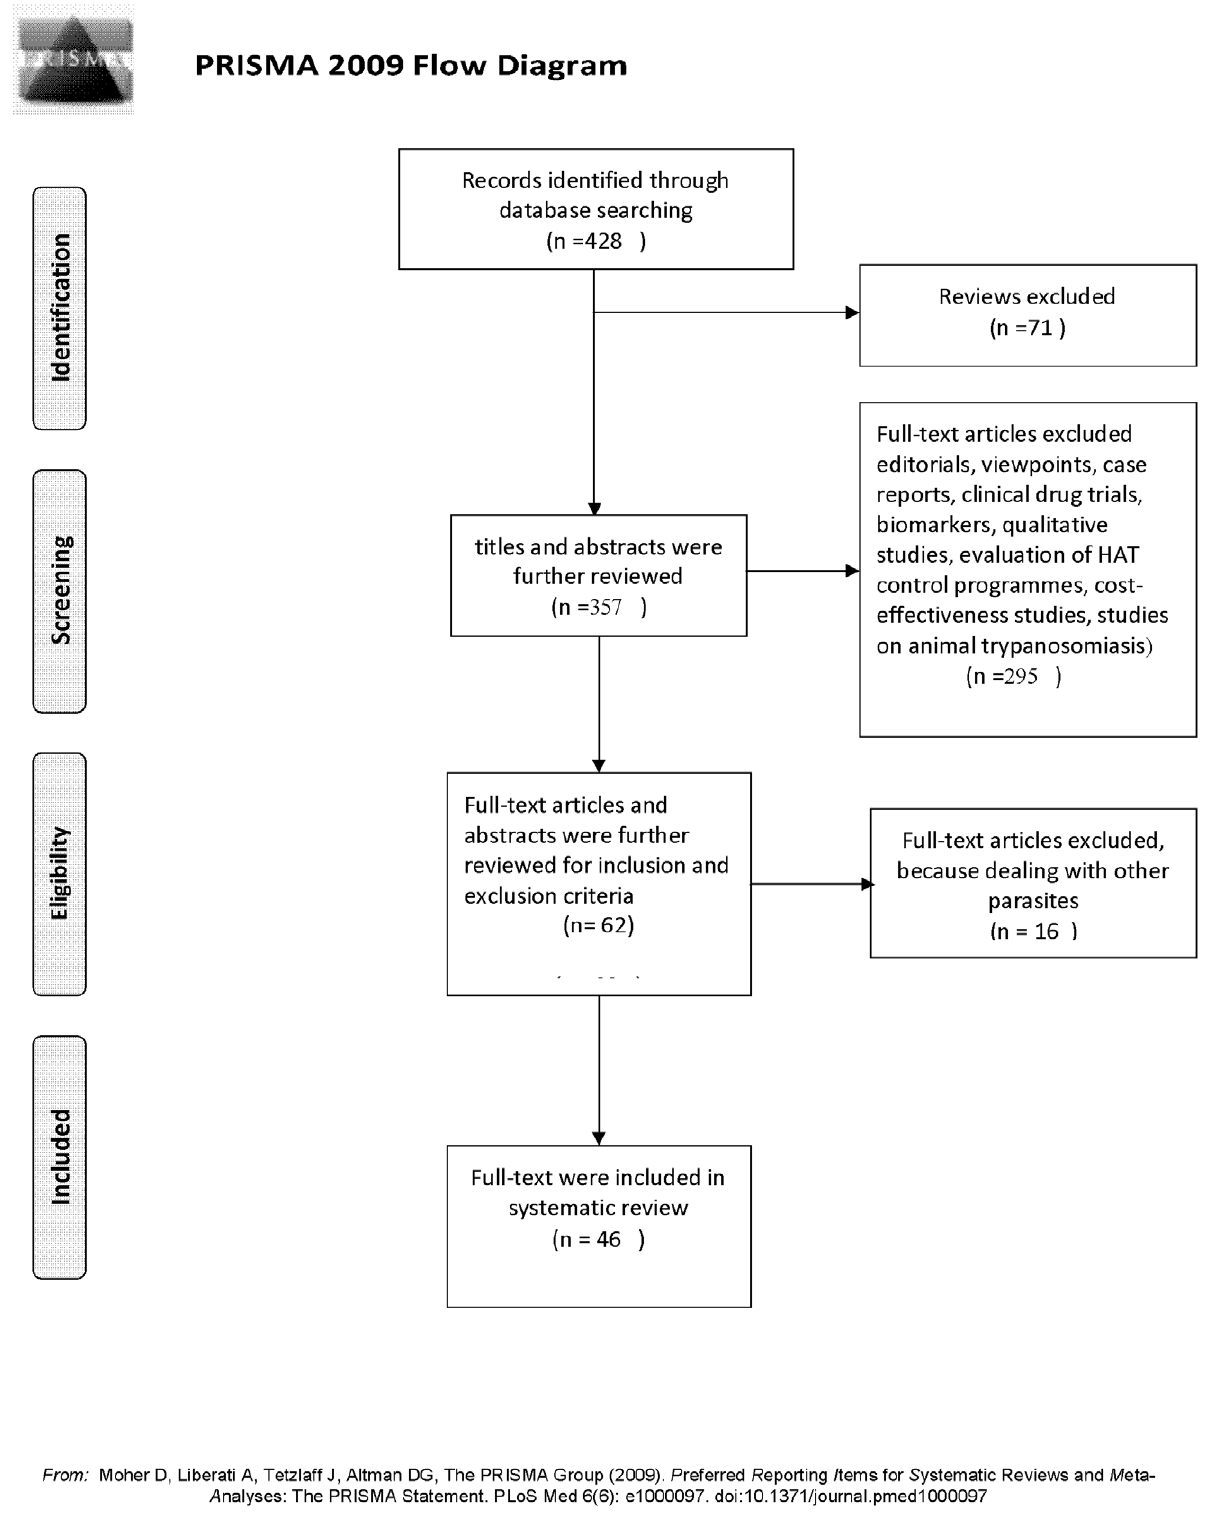
Figure 1. Flow diagram for study selection.